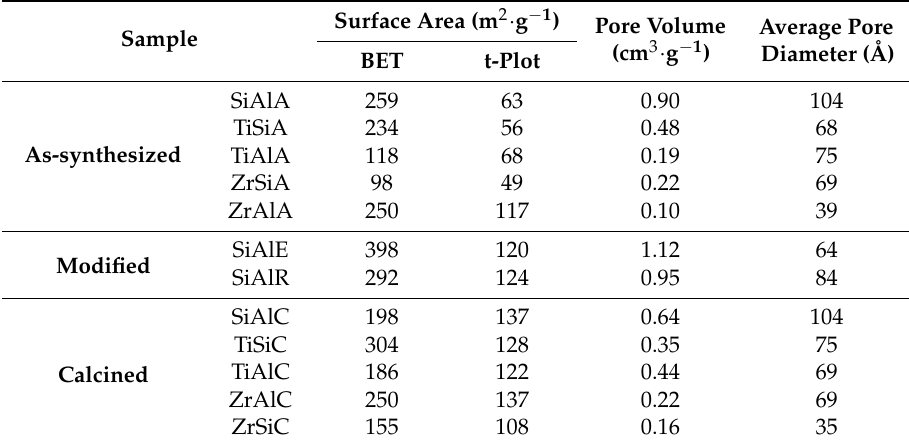
Table 1. Nomenclature and textural properties of the